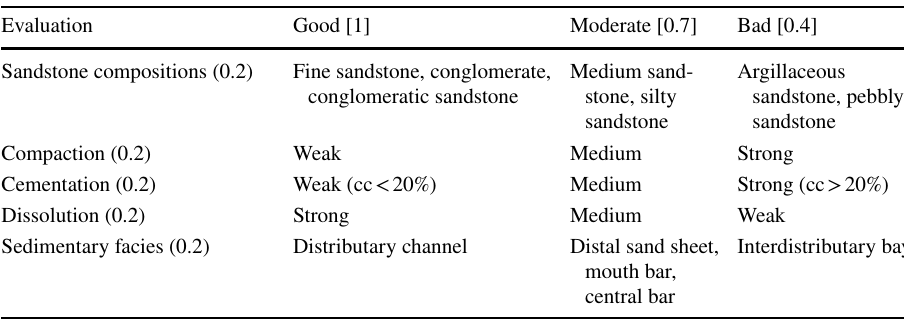
evaluating of reservoir type classifications of Oligocene sandstone reservoirs in the Lengdong area